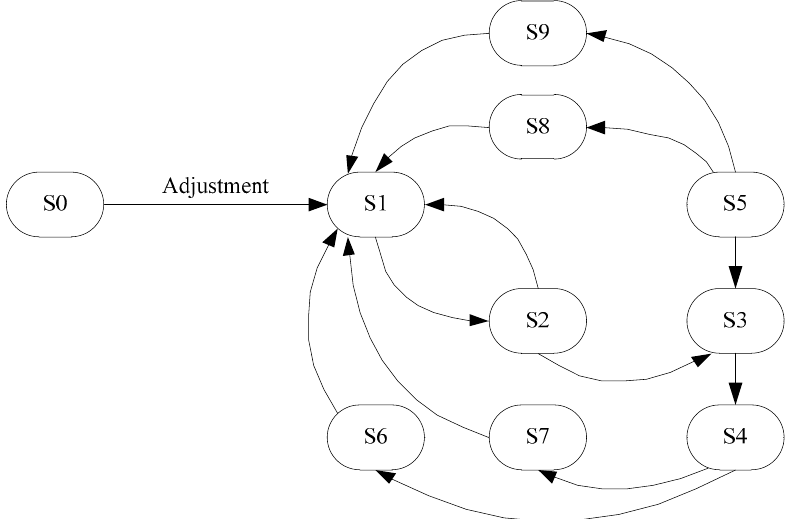
Figure 5. The reachability graph of the states for studying the process dynamics of the anode voltage adjustment for the Geiger–Mueller counter.